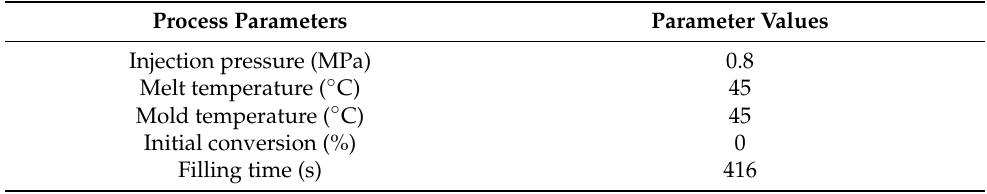
Table 3. The parameters of the filling process.